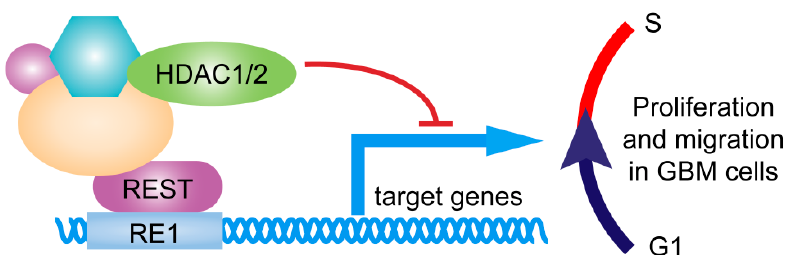
Figure 9. REST was a key regulator of GBM cells proliferation and migration. REST binds to RE1 motif and recruits cofactors to repress downstream genes, triggering cell cycle G1–S transition to maintain proliferation and migration in GBM cells.